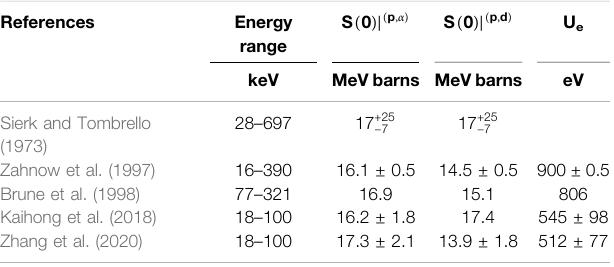
TABLE 2 | List of the extracted S(0) factor and the electron screening potential U e value of different direct measurements of 9 Be destroyed reactions.